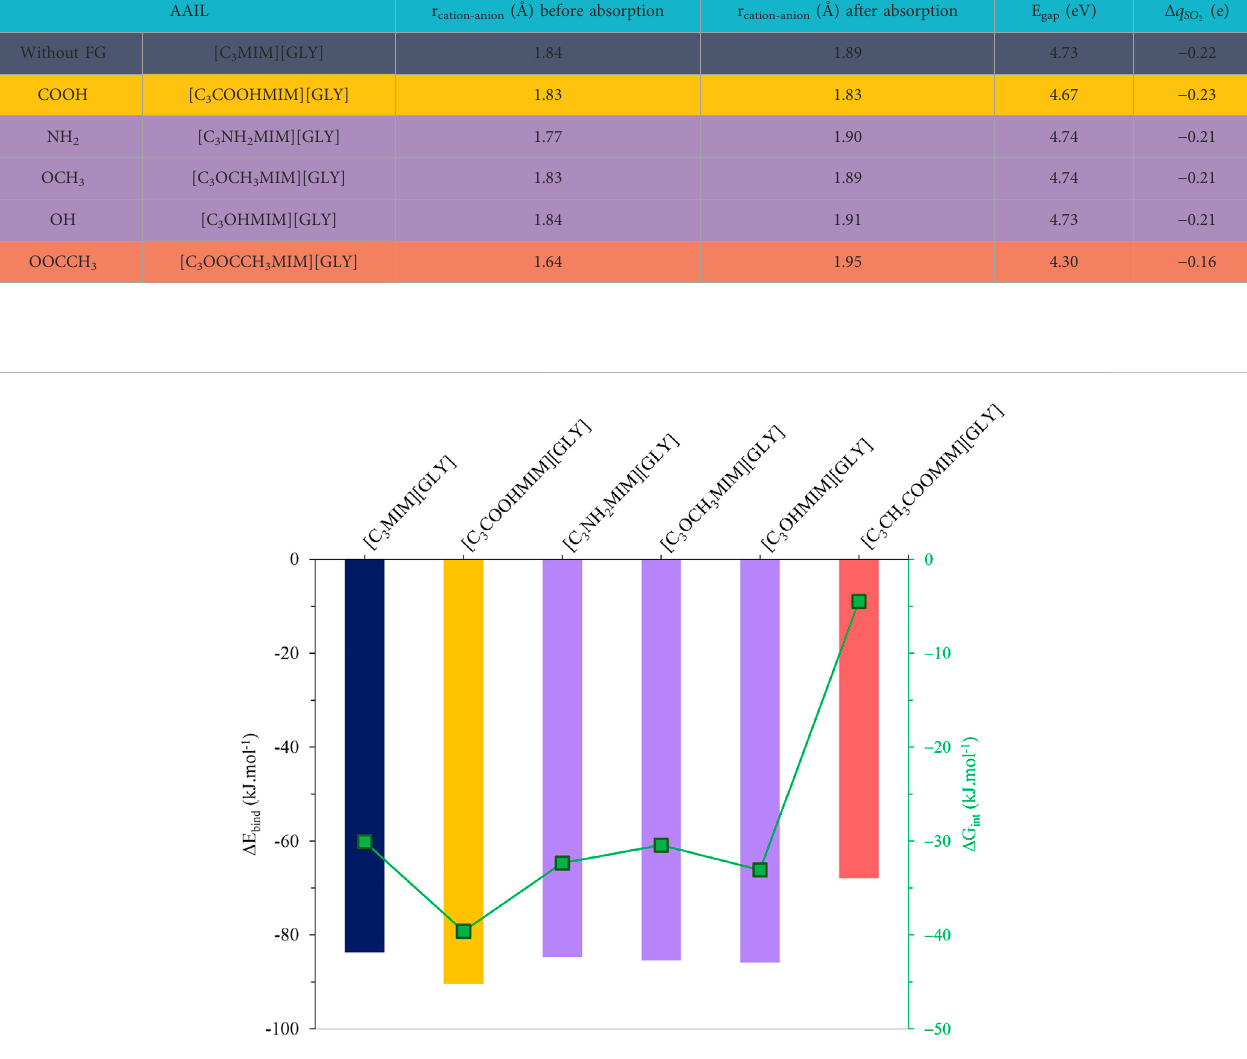
SO 2 BE and Δ G int values of absorption for the studied AAIL